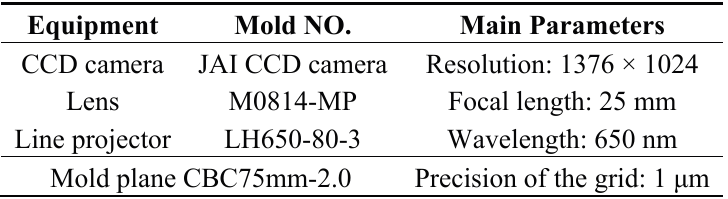
Figure 10. Experimental equipment for measuring shafts: ( a ) shaft 1; ( b ) shaft 2. Table 2. Experimental equipment